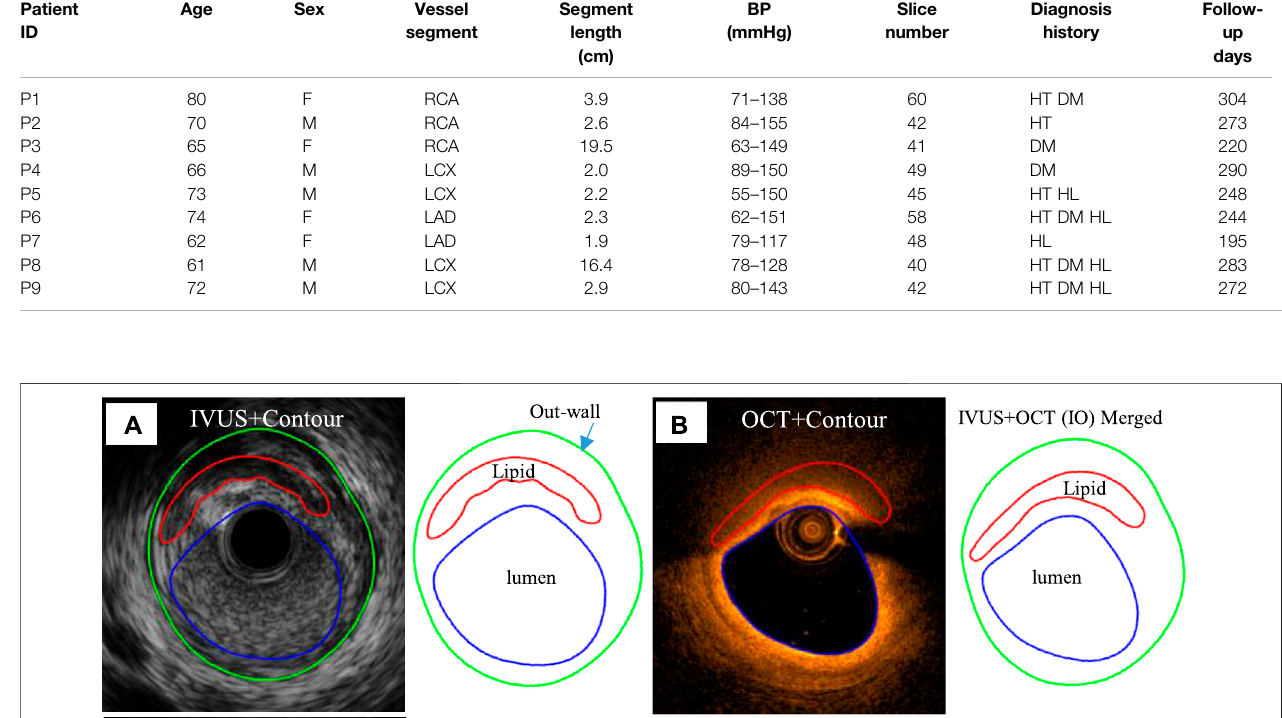
TABLE 1 | Patient demographic and clinical information. F: female; M: male; BL: baseline; FU: follow-up; HT: hypertension; DM: diabetes mellitus; HL: hyperlipidemia. Patient ID